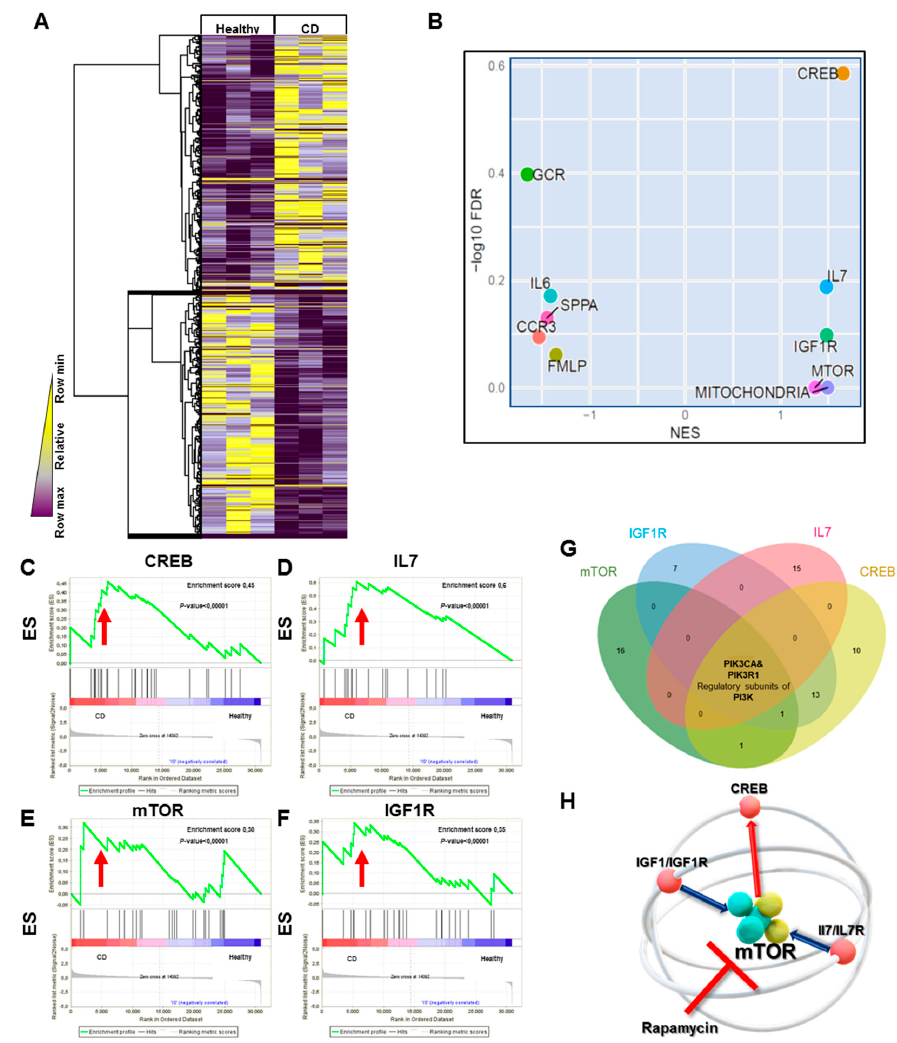
Figure 1. CD HILECs display peculiar transcriptomic signatures. ( A ) Heatmap showing differentially modulated genes with statistical significance ( p ≤ 0.05) in CD HILEC versus healthy cells ( n = 3 patients/group). ( B ) Scatter plot visualizing gene set enrichment analysis (GSEA) of transcriptomic results according to statistical significance (log10 false discovery rate (FDR), y-axis) as a function of the normalized enrichment scores (NES, x-axis). C–F. GSEA enrichment plots of gene sets in CD HILECs compared to healthy cells, showing enrichment scores (ESs) for CREB ( C ), IL7 ( D ), mTOR ( E ), and IGF1R ( F ). ( G ) Venn diagram showing the intersection among genes belonging to the indicated pathways. ( H ). Cartoon showing the interaction among the indicated pathways.